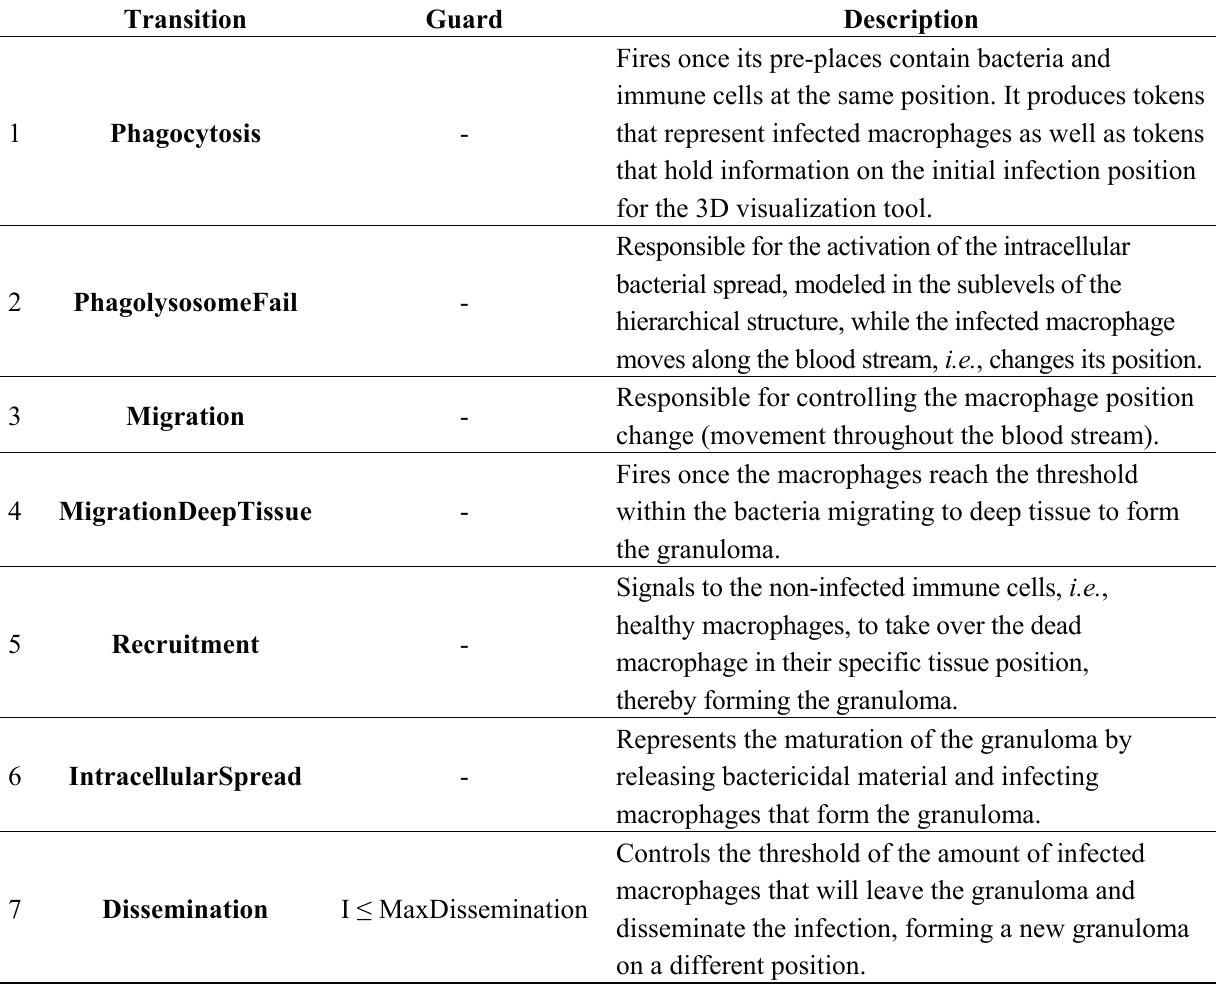
Table 4. Set of transitions composing level 1 of the model.